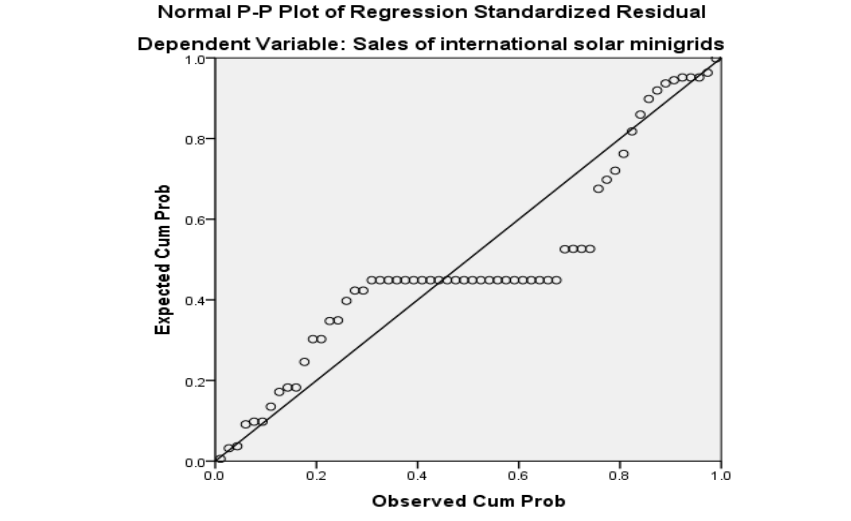
Figure 2: Scatter plots of Residuals Indicating Curvilinear and Linear Relationships; Source: Researchers’ constructs 2021. Normality and multicollinearity assumptions were also tested. The assumption in multiple regression is that residuals are normally spread. No Multicollinearity—Multiple regression adopts that independent variable are not highly correlated with each other. In this hypothesis, Variance Inflation Factor (VIF) values are tested. Several authors recommended a formal detection-tolerance or variance inflation factor (VIF) for multicollinearity: where R 2 is the coefficient of determination of regression of explanator j on all the other explanatory. A tolerance of less than 0.20 or 0.10 and/or a VIF of 5 or 10 and above indicates a multicollinearity problem.